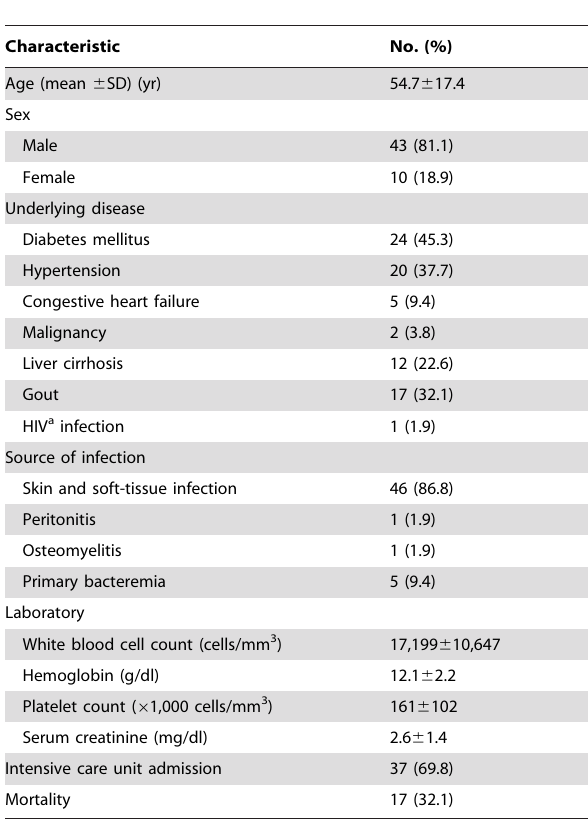
Table 2. Demographic Characteristics, Underlying Diseases, Clinical Conditions, and Sources of Infection among 53 Cases of Streptococcal Toxic Shock